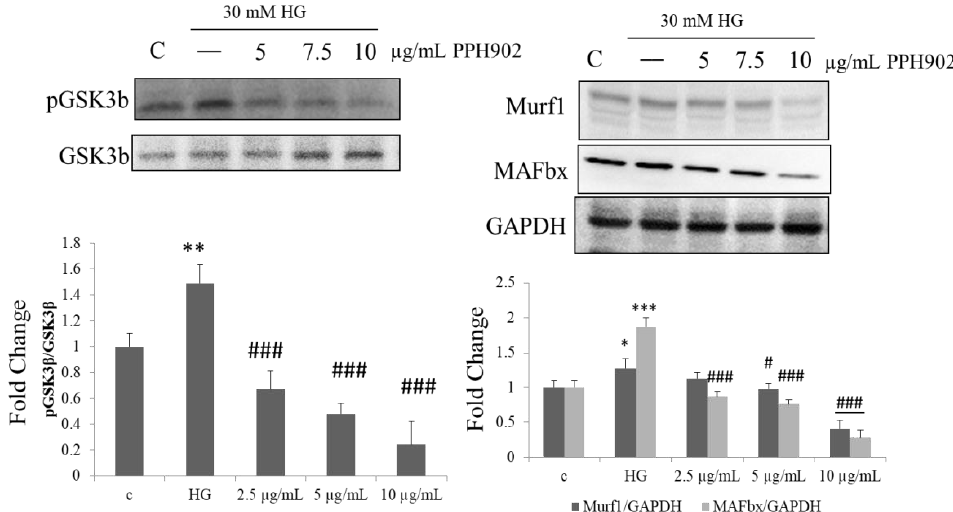
Figure 8. Effect of PPH902 on high-glucose-induced muscle atrophy mechanism: Representative Western blotting shows changes in the levels of GSK3b phosphorylation, MAFbx and MyHC in C2C12 cells. * p < 0.05, ** p < 0.01 and *** p < 0.001 indicate significant difference with respect to control groups and # p < 0.05 and ### p < 0.001 indicate significance differ- ence with respect to the high glucose challenge groups.